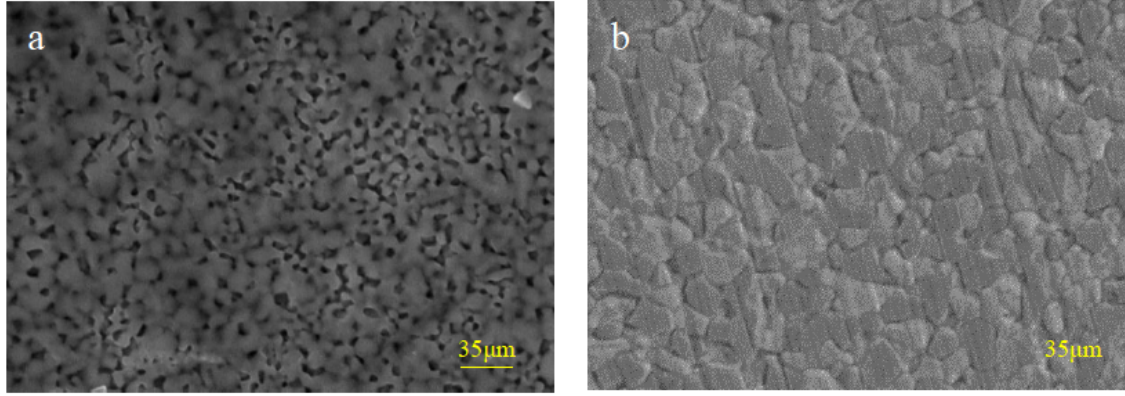
where F is Cu 13.7 Sn, B is Cu 5.6 Sn, P is Cu 3 P, δ phase is Cu 41 Sn 11